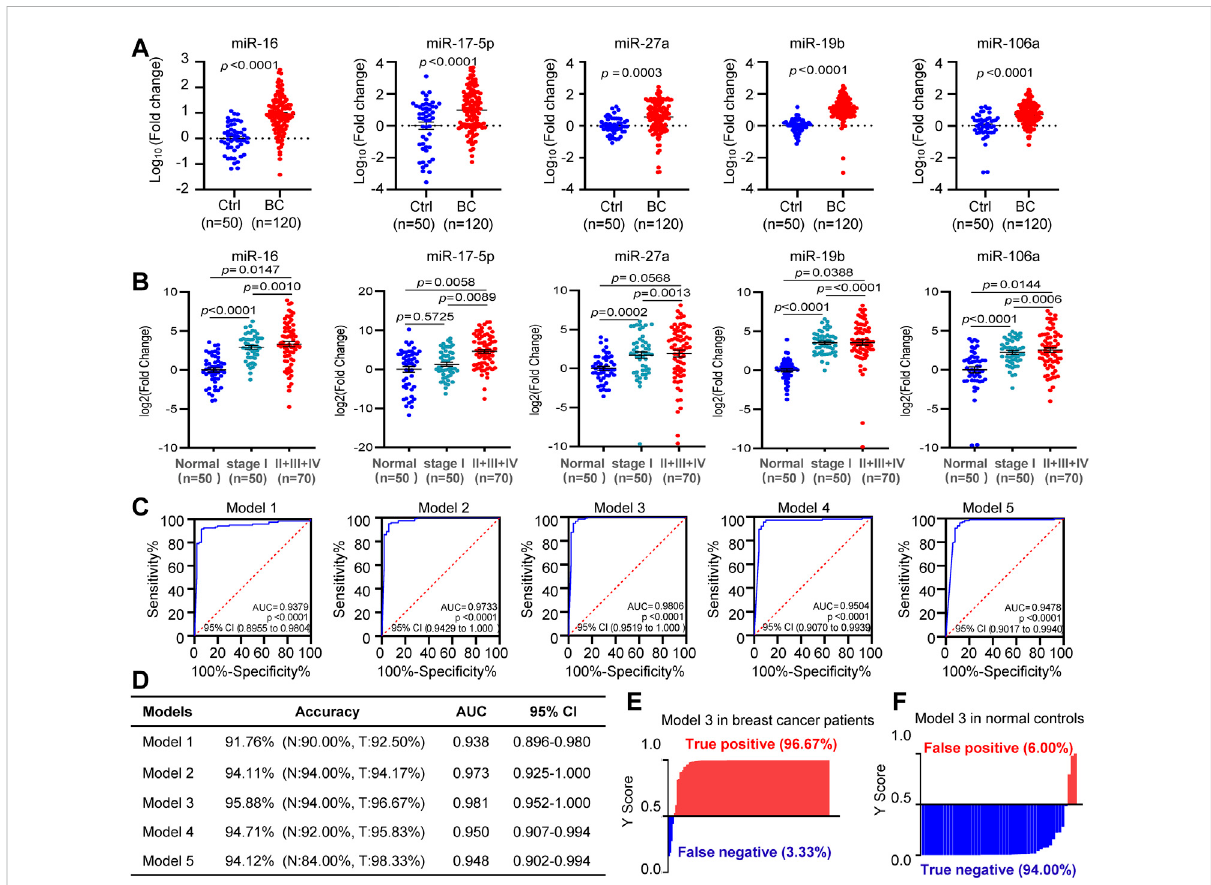
FIGURE 5 Diagnostic model development. (A) . The differential expression analysis of circulating miR-16, miR-17, miR-27a, miR-19b, and miR-106a in all the120 BC patients and 50controls. (B) . Higher levels ofcirculating miR-16,miR-17, miR-27a, miR-19b, and miR-106a in patients at stages II or III or IV than that at stage I. (C) , (D) . ROC curves showing diagnostic accuracy, AUC and 95% CI of the fi ve models tested in the 120 BC patients and 50controls. ( E ), (F) . Y score distributionplot of themiR-19b-based 3-miRNA model (model 3) inthe 120 BC patients (E) and 50normal controls (F) showing the true-positive rate (97%) in BC patients and true negative rate (94%) in normal controls. Y score > 0.5 was diagnosed as